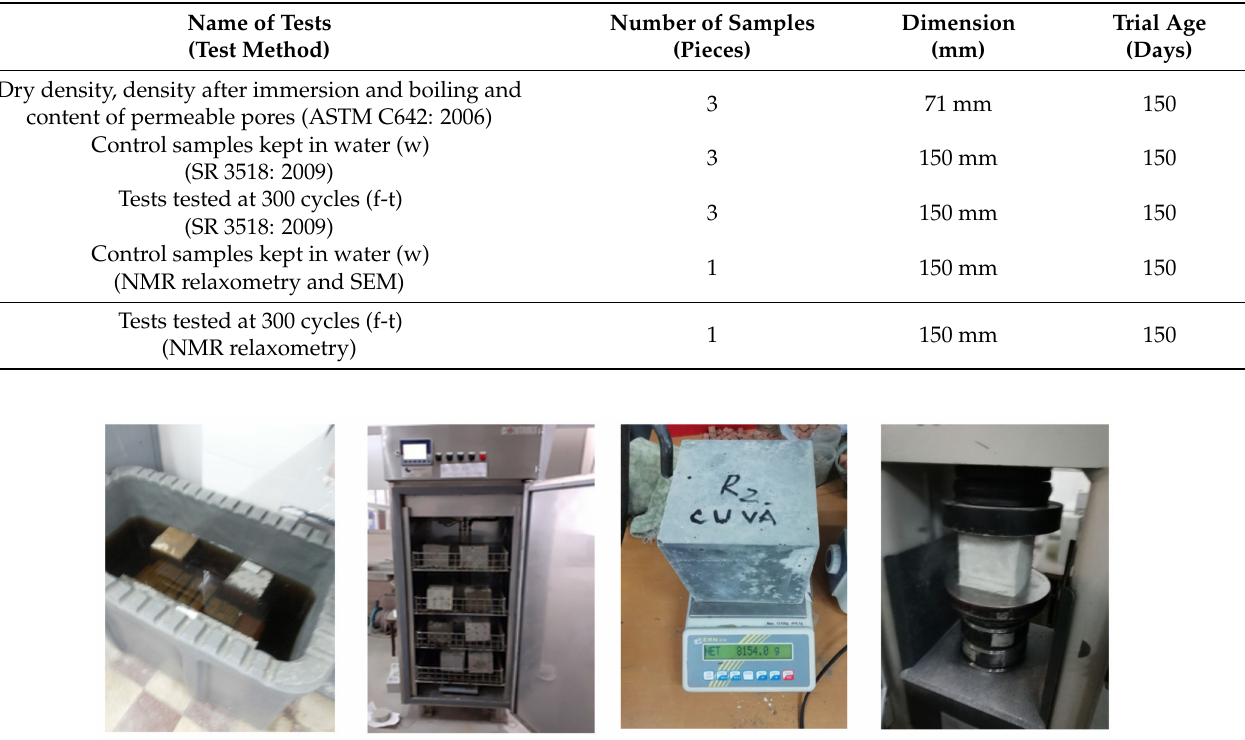
Table 4. Number of samples prepared for testing in each composition.